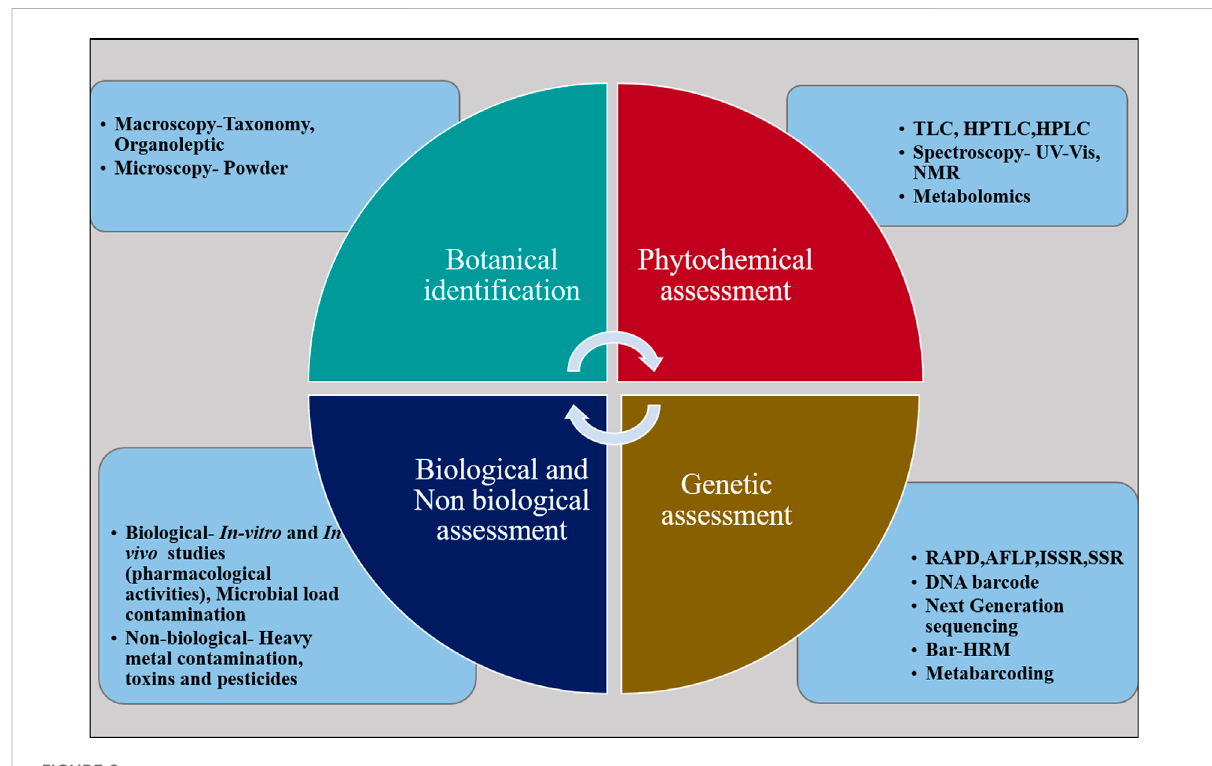
FIGURE 2 Parameters used in quality assessment of herbal